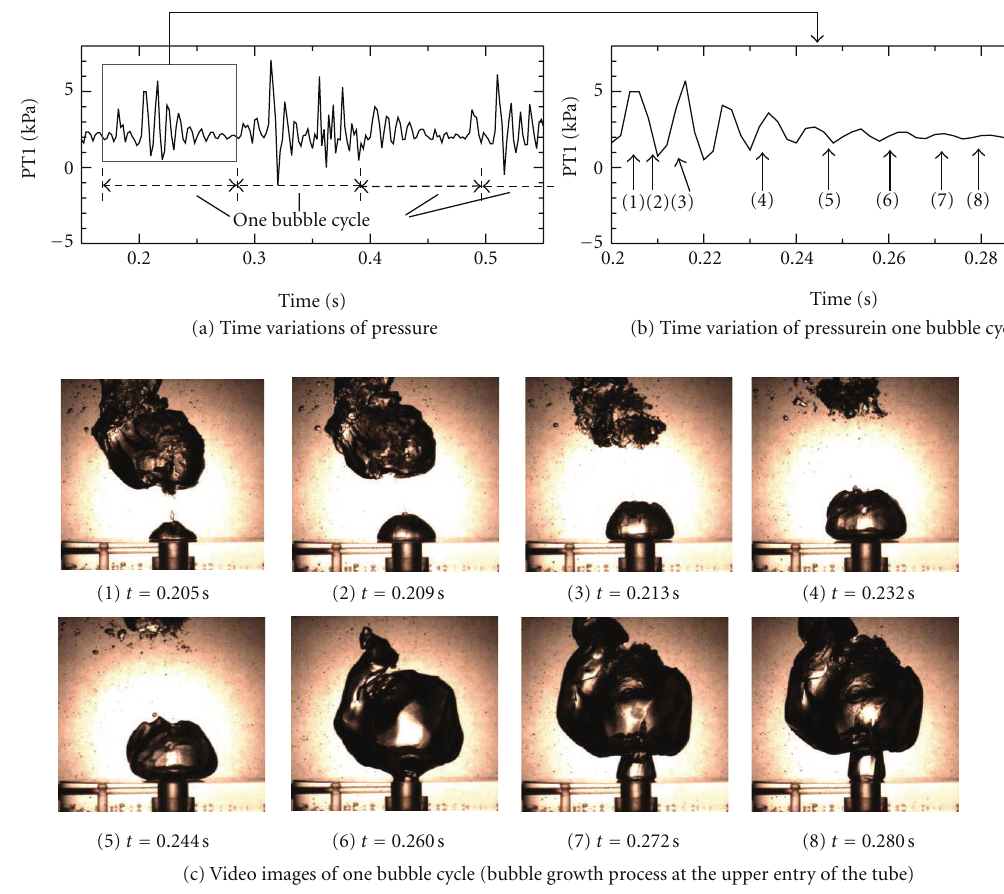
Figure 4: Time variations of pressure at the upper entry of the tube (PT1) and corresponding bubble formation and expansion process (tube diameter D = 12 mm, j ∗ 0 . 5